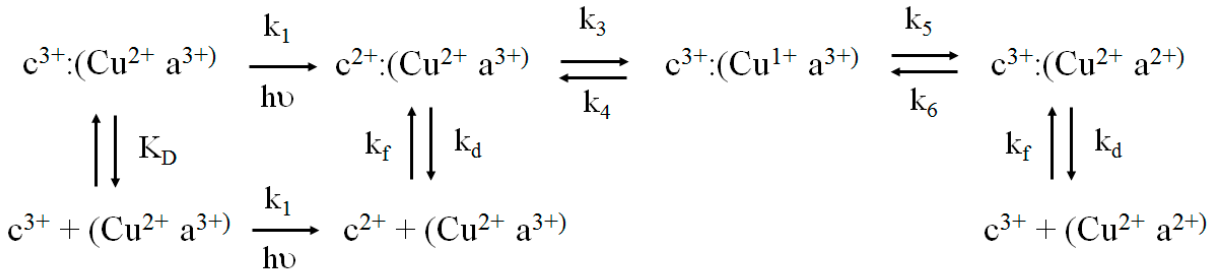
Scheme 2. Mechanism of photoinduced electron transfer from Ru-39-Cc to CcO.